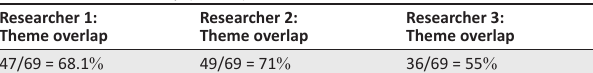
TABLE 3: Theme overlap ( N =